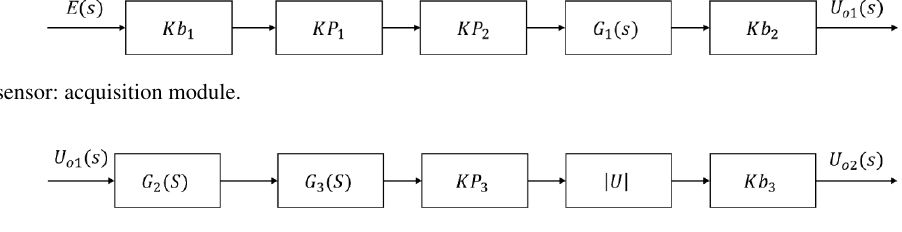
Figure 5. EMG sensor: pre-processing